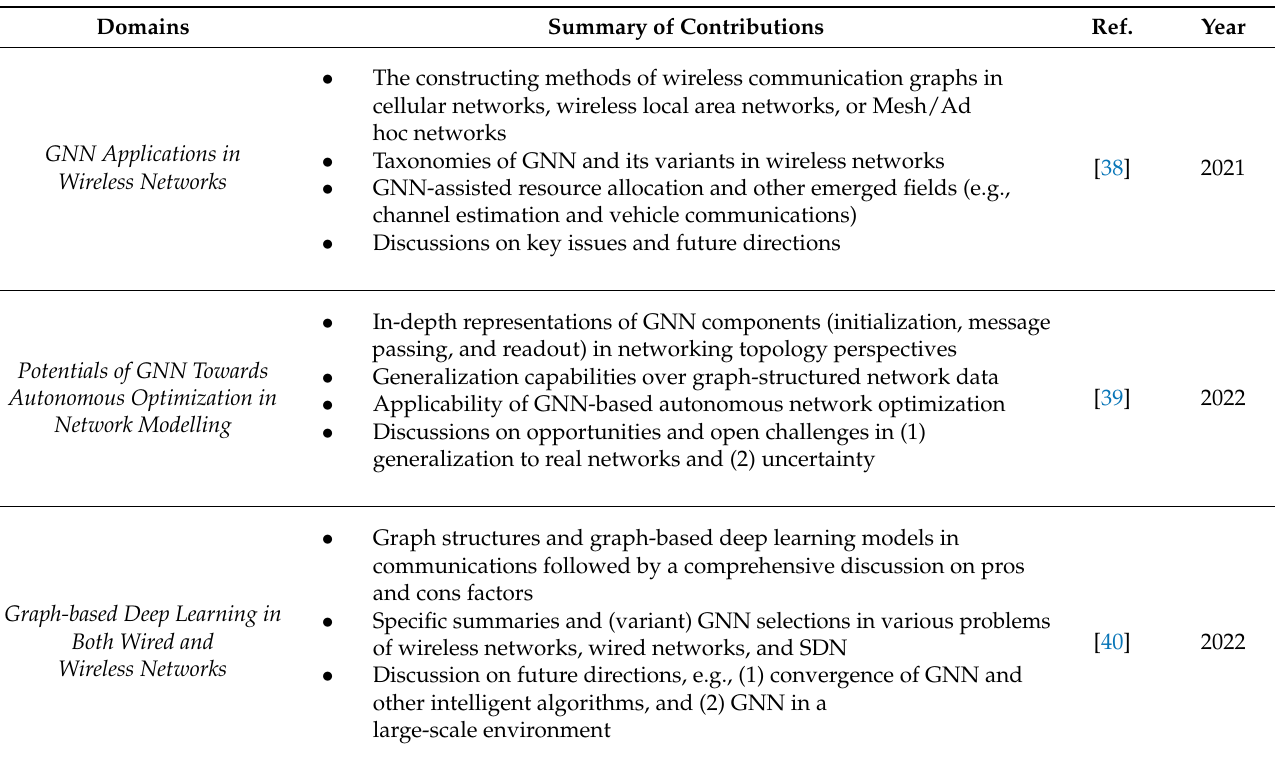
Table 2. Summary of Existing Surveys on Graph-Based Approaches in Communication